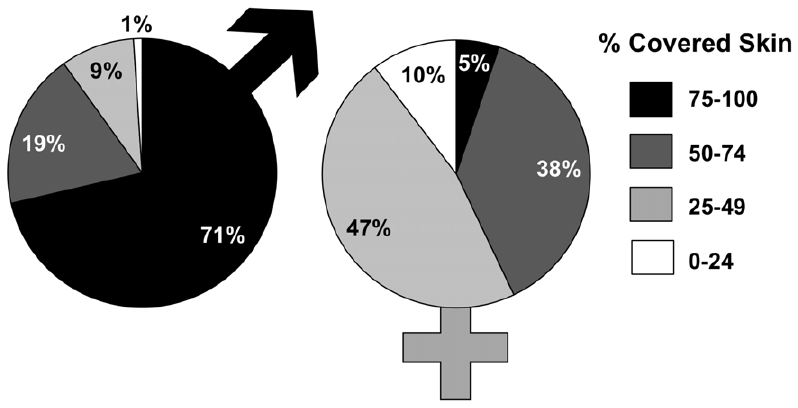
Figure 1. Propensity to cover skin among virtual males and females. Shown is the percentage of Second Life male and female avatars in relation to the percentage of covered skin.